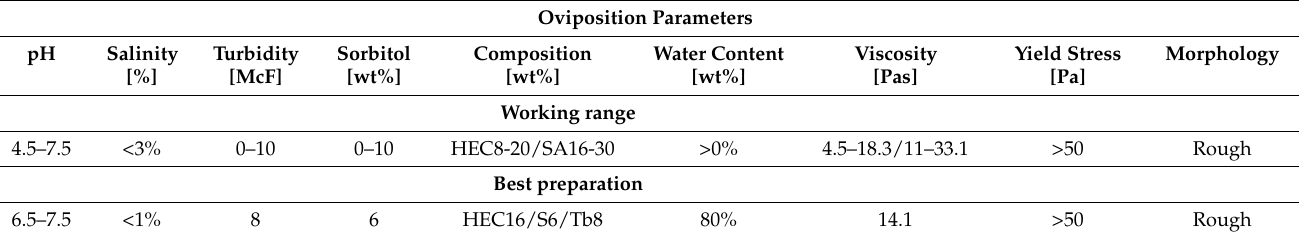
Table 2. A panel of range for oviposition parameters and substrate composition identified through tests. Oviposition